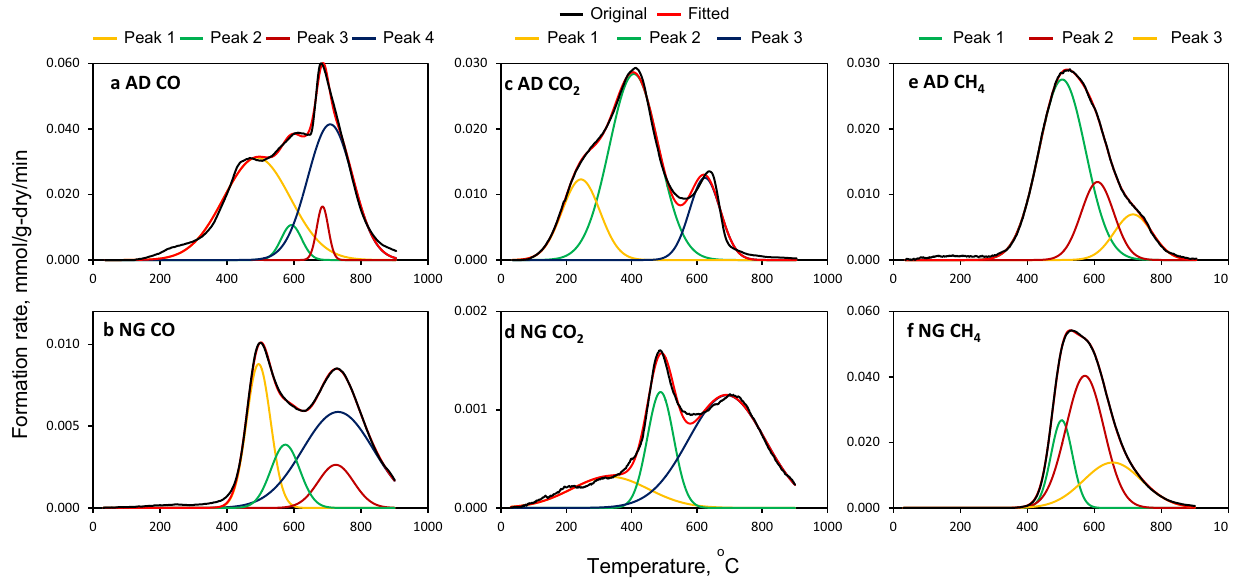
Fig. 6 Gas evolutions and deconvolutions as a function of the temperature for coal AD and NG Table 4 Deconvolution results of coal AD and NG